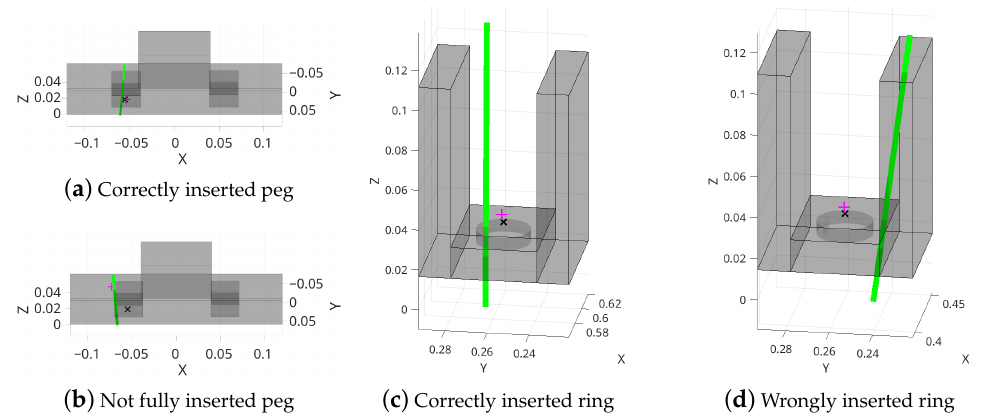
Figure 7. Contact vector estimation in four examples of the considered assembly tasks. A schematic model of the Cranfield base plate and the casting mold is shown in ( a – d ), respectively. The green line shows the contact vector, whereas the pink plus symbol shows the robot’s tool center point (TCP) at the time of contact and the black cross shows the target reference